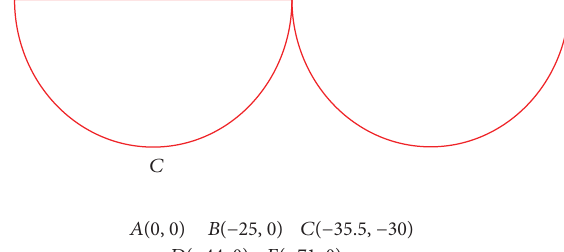
Figure 4: Assumption for the electric field lines.